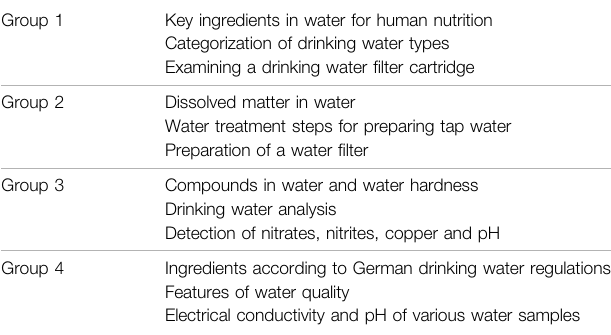
TABLE 2 | Group-speci fi c topics of the